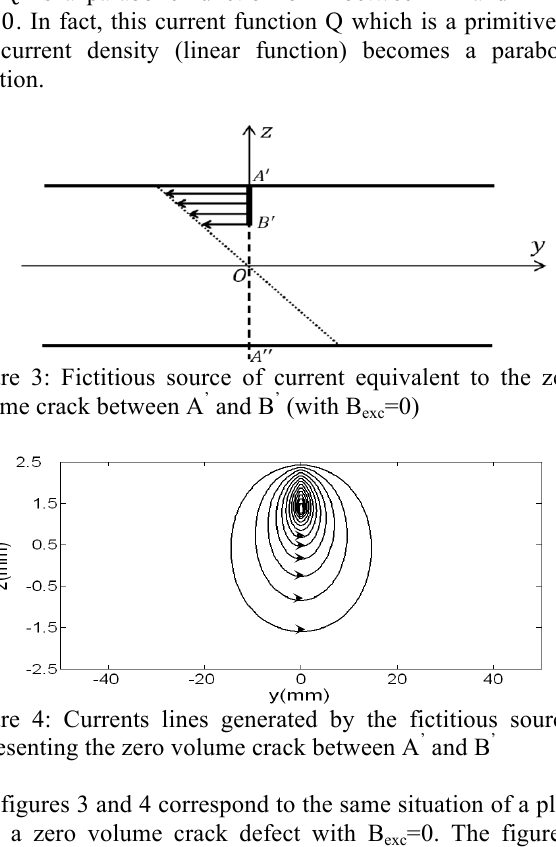
Figure 4: Currents lines generated by the fictitious source representing the zero volume crack between A ’ and B ’